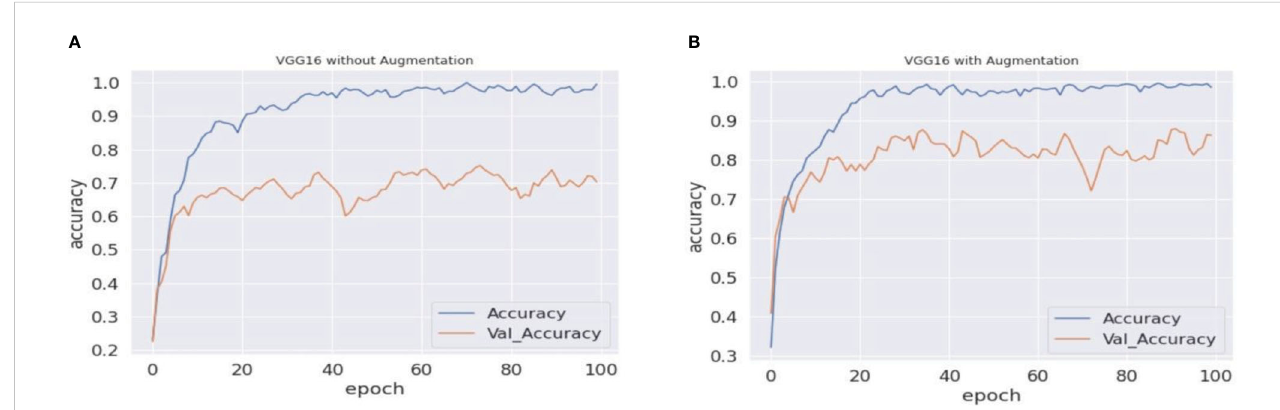
FIGURE 5 VGG16 accuracy comparison. (A, B) The graphical representation of validation and training accuracy results of the VGG16 architecture on augmentation and nonaugmentation datasets for comparison. During the training process with the baseline dataset, the training curve reaches a saturation point after approximately 40 epochs, while the validation curve shows oscillation in the overall training process. In (B) , on the other hand, the training curve reaches a saturation point after approximately 30 epochs, while the validation curve shows better results and less oscillation.